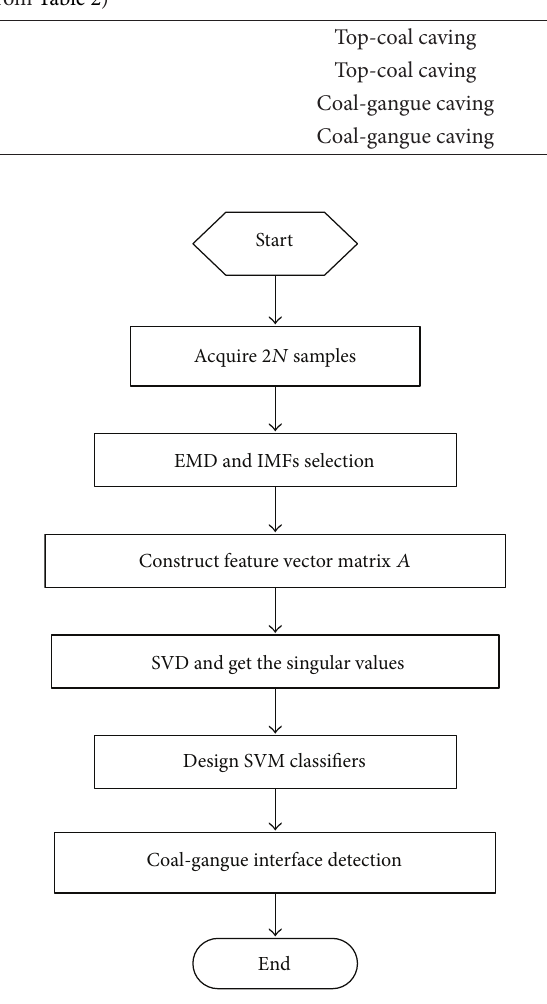
Figure 4: The flowchart of EMD-based SVD and SVM.